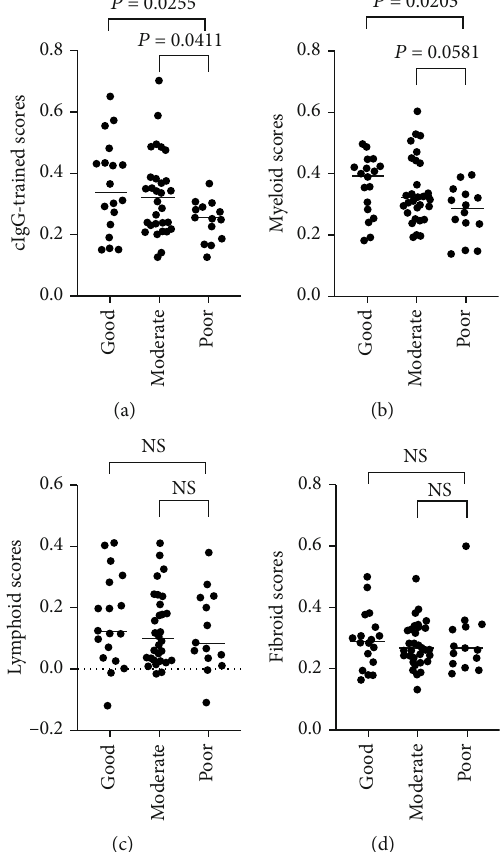
Figure 7: cIgG-trained signatures correlate with clinical response to in fl iximab therapy. Analysis of synovial tissue transcriptome from 62 RA patients in GSE21537 before the initiation of in fl iximab (anti-TNF α treatment). The clinical outcome by in fl iximab at 16 weeks was de fi ned by EULAR response criteria. Scores versus EULAR responses are plotted for (a) cIgG-trained scores and the synovial (b) myeloid, (c) lymphoid, and (d) fi broid pathotypes. The Kruskal – Wallis test was performed, followed by post hoc testing by Dunn ’ s multiple comparison